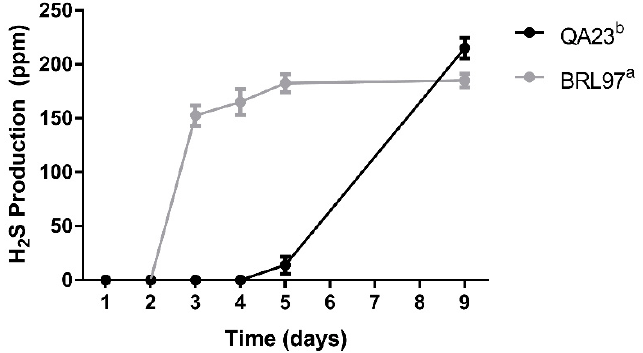
Figure 4. Cumulative H 2 S production (ppm ± SEM) by different yeast strains when fermented in the presence of 50 mg/L SO 2 . Treatments with different superscript letters indicate significant differences in overall H 2 S production dynamics (2-factor repeated measures ANOVA, α = 0.05).